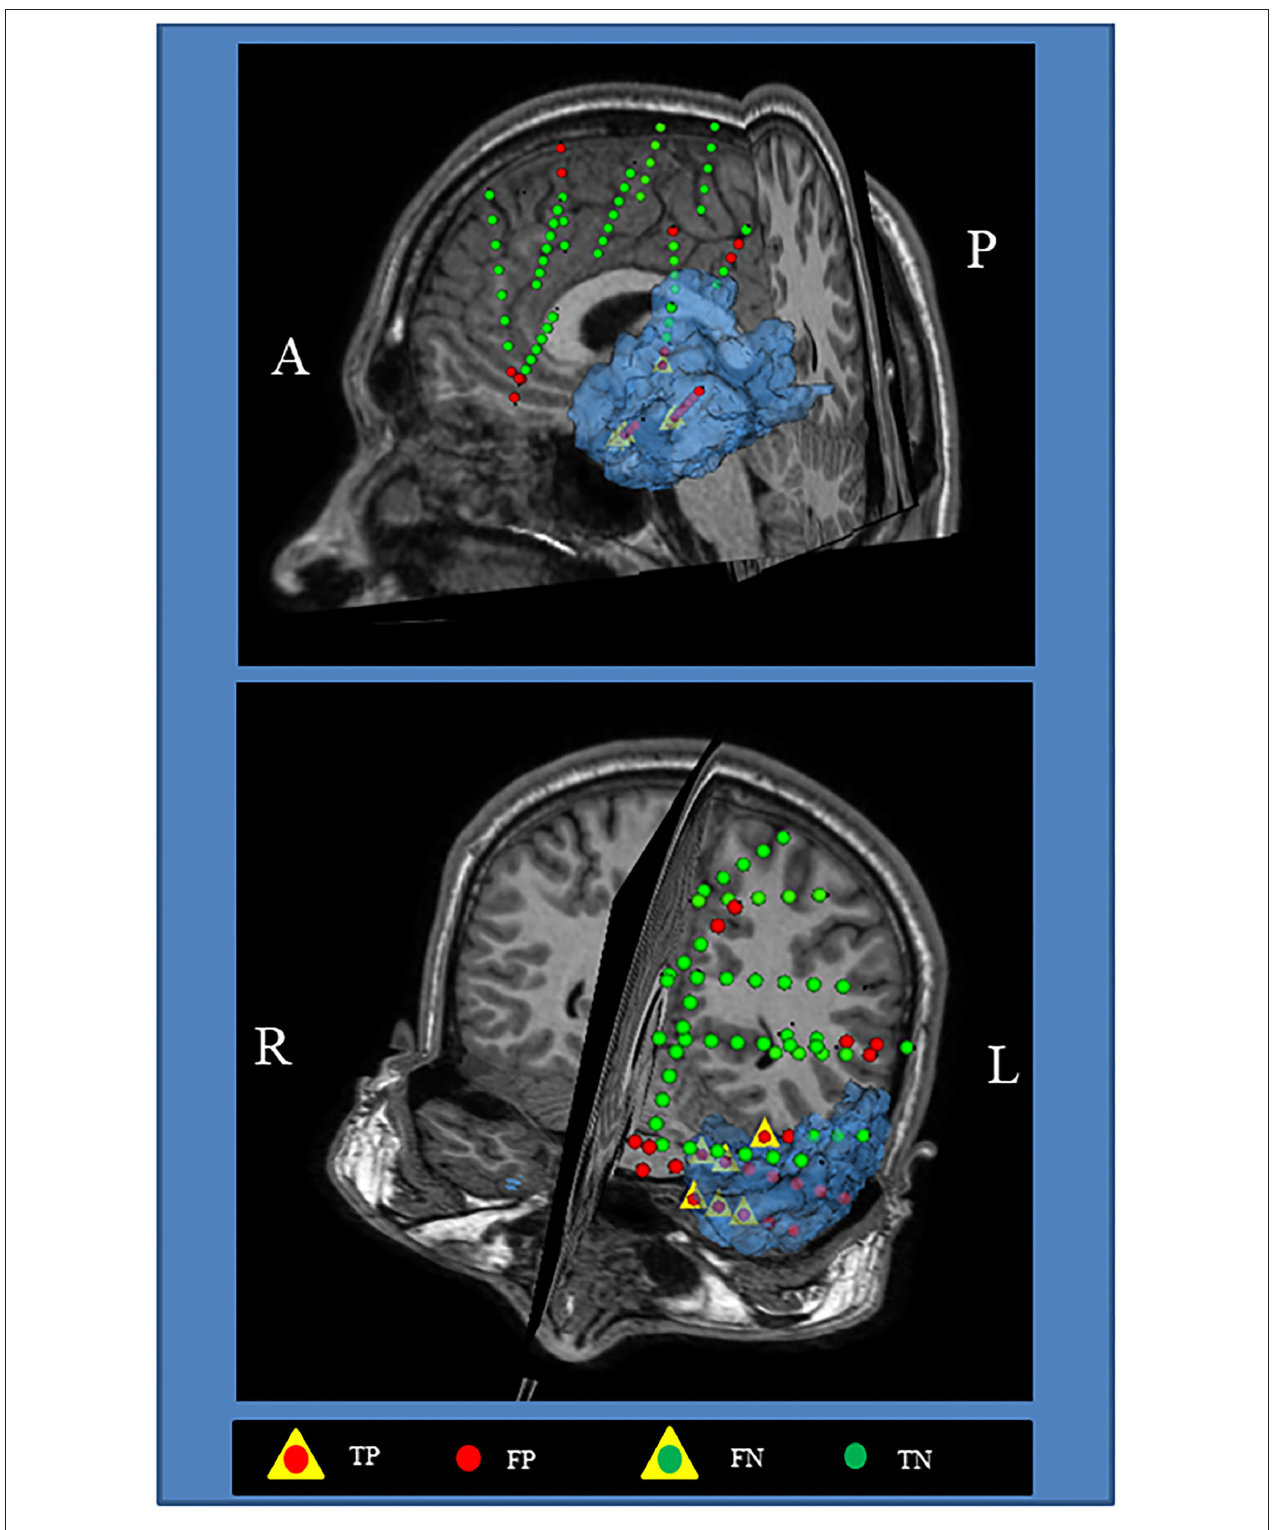
FIGURE 7 | Visualization of the surgical 3D scene for a representative patient (pt2). The Blue area indicates the final resected zone. Red and green dot points indicate leads classified as epileptogenic zone (EZ) A, anterior; L, left; P, posterior; R, right.